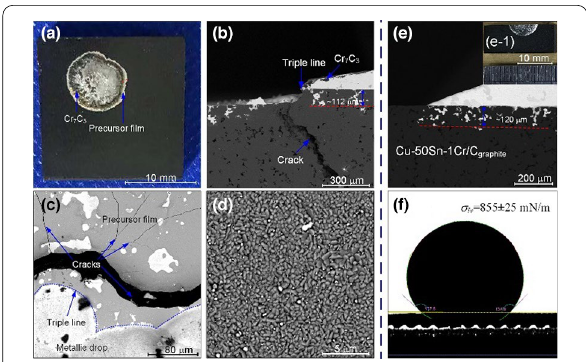
Figure 8 ( a ) Top view of macroscopic appearance for Cu-20Sn-1Cr/ C graphite after wetting, ( b ) Cross-sectional interfacial microstructures at close of triple line, ( c ) Top view of details at close of triple line, ( d ) Detailed microstructures of PF in ( c ), ( e ) microstructures at close of triple line and ( e‑1 ) Top view of macroscopic appearance for half of Cu-50Sn-1Cr/C graphite sample, ( f ) image of drop for surface tension